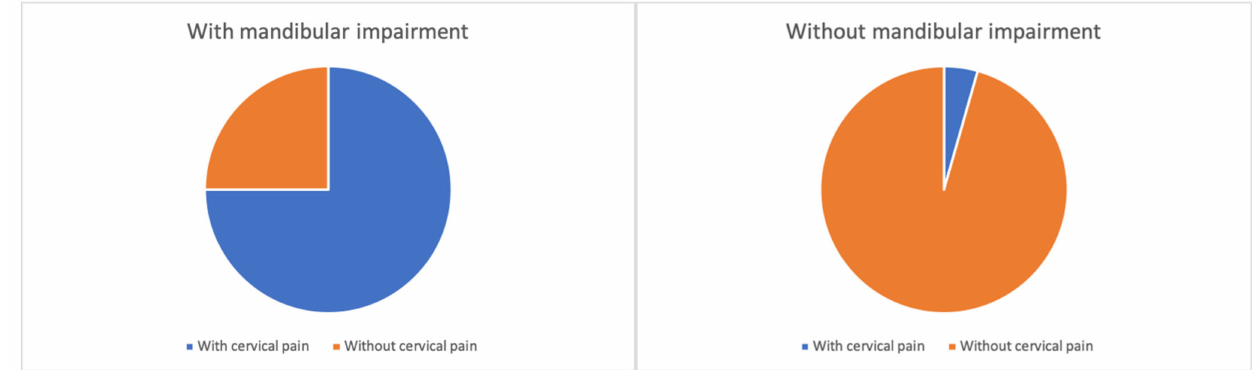
Figure 2. Graphs showing the data distribution according to the presence of mandibular